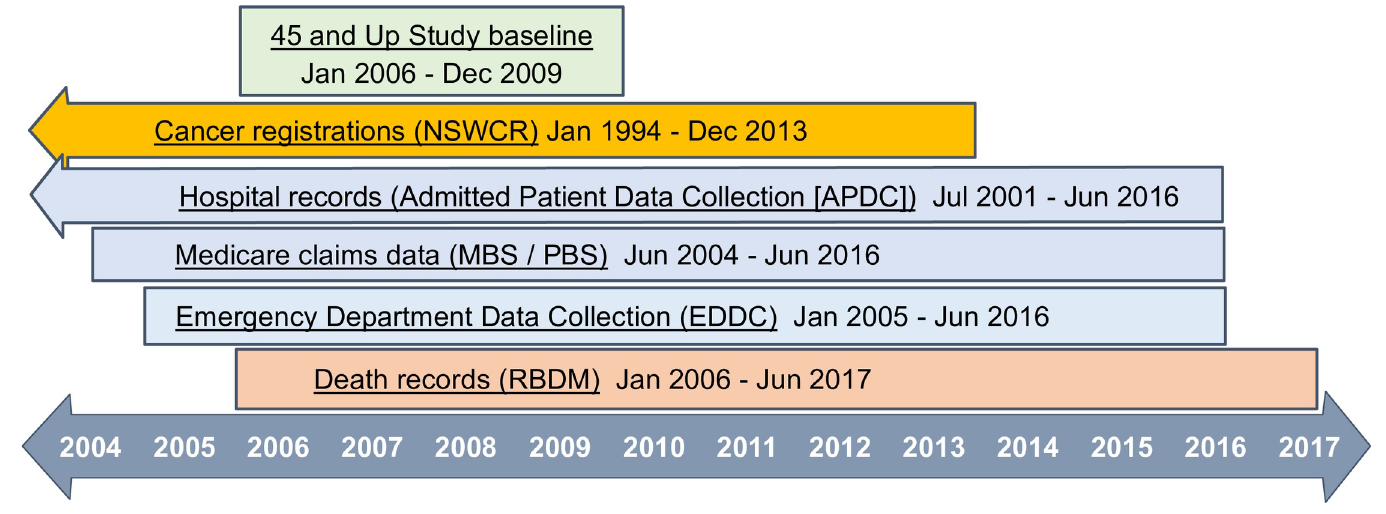
Fig 1. Data sources and date coverage. NSWCR: New South Wales Cancer Registry; MBS: Medicare Benefits Schedule; PBS: Pharmaceutical Benefits Scheme; RBDM: Registry of Births, Deaths and Marriages. Reproduced from reference [5].